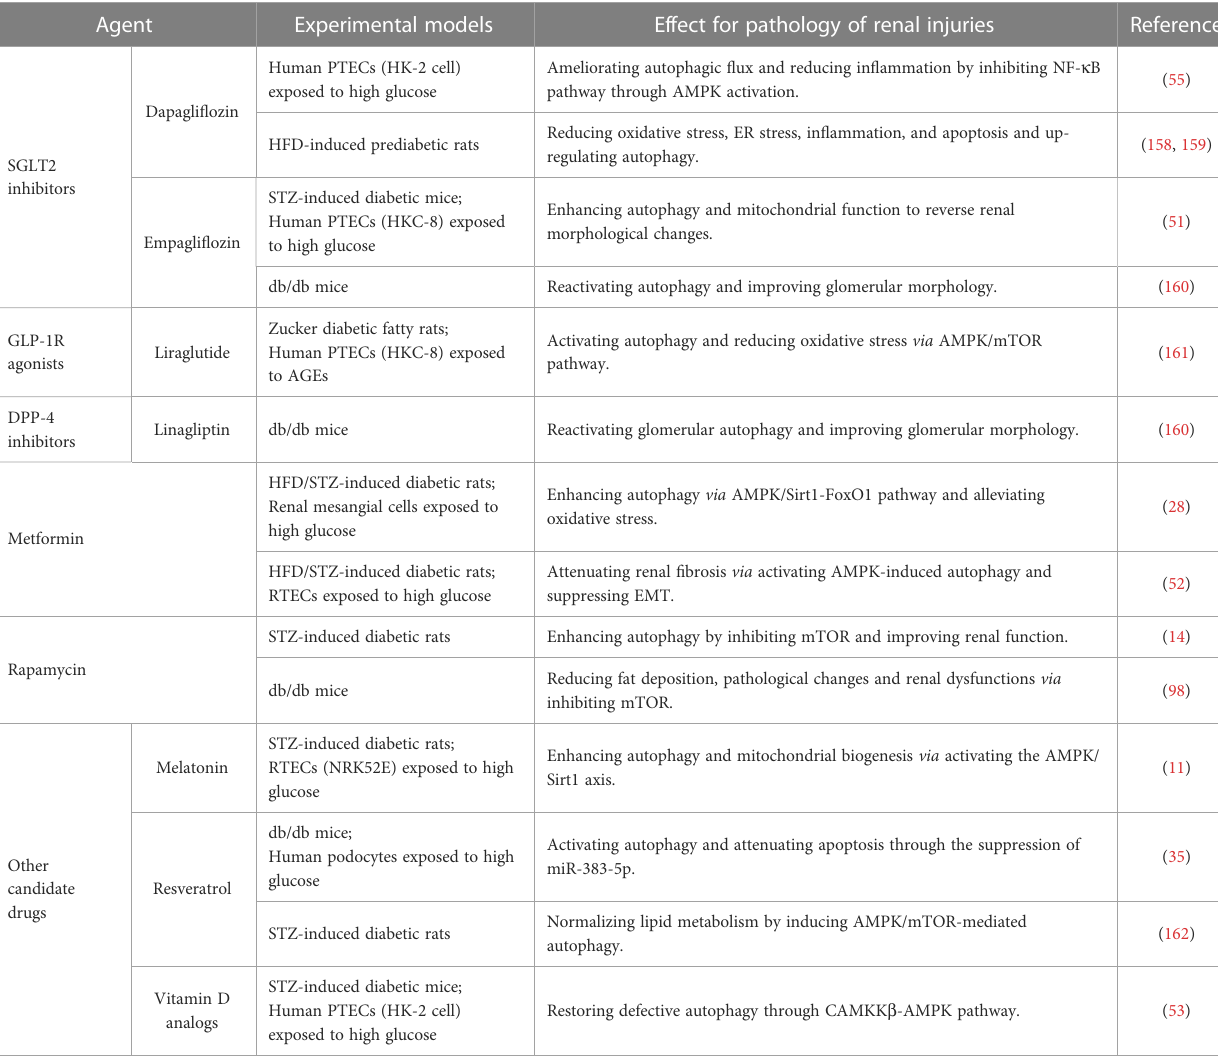
TABLE 2 Agents targeting autophagy for diabetic nephropathy. Agent Experimental